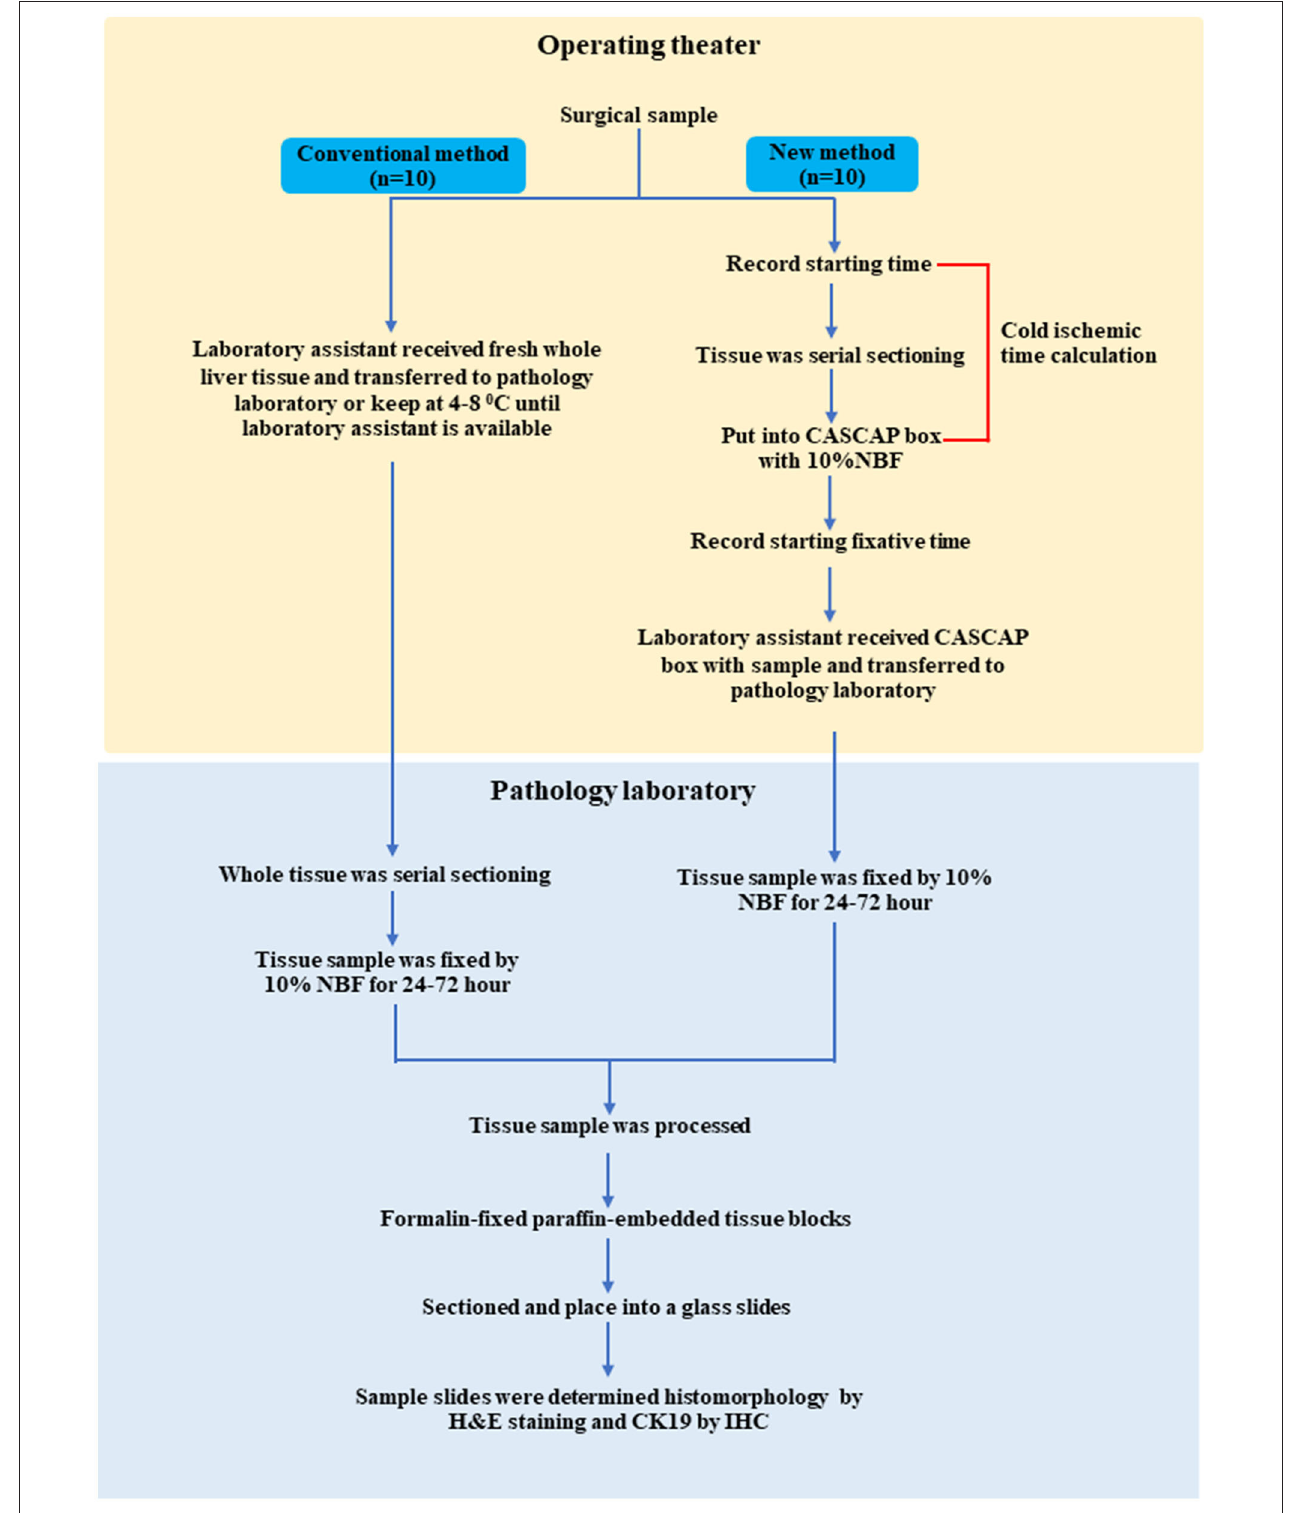
FIGURE 1 | Experimental